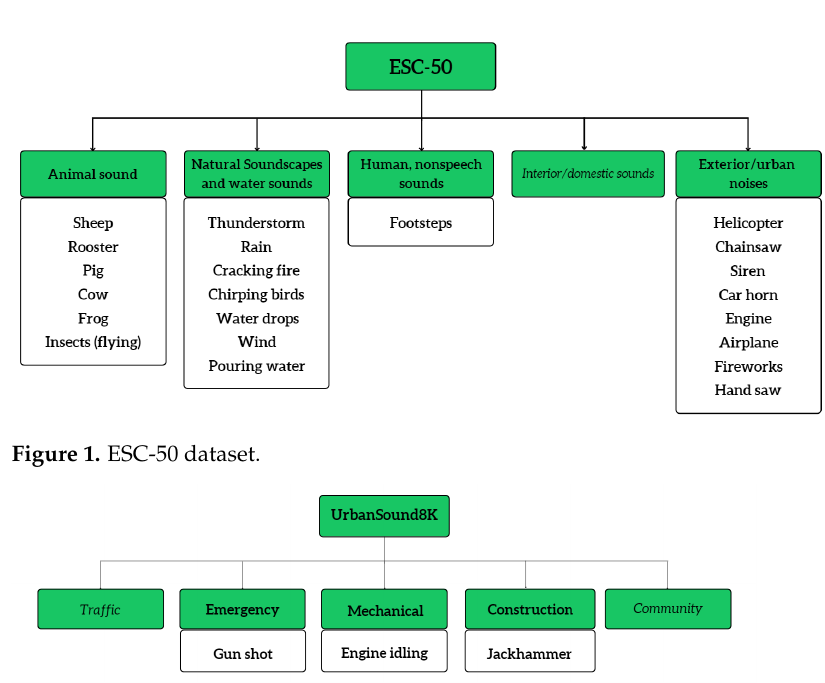
Figure 2. Urbansound8K